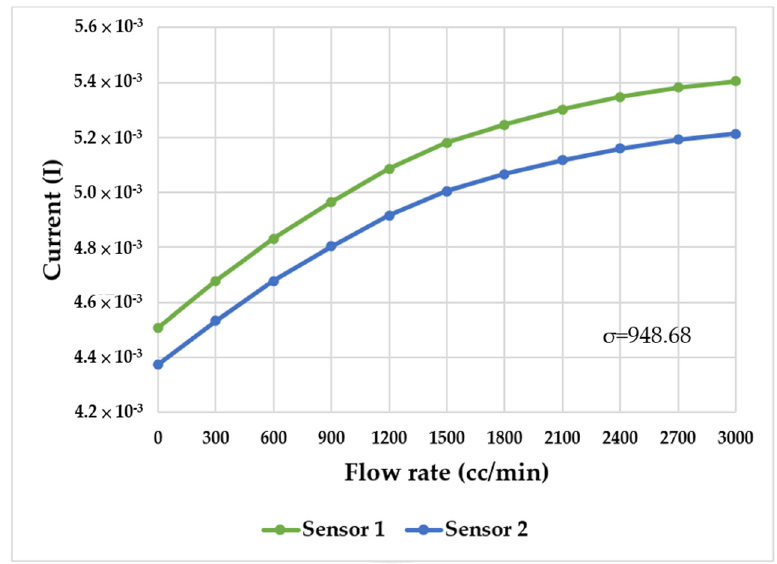
Figure 8. Calibration curve of the microflow sensor (original current value).